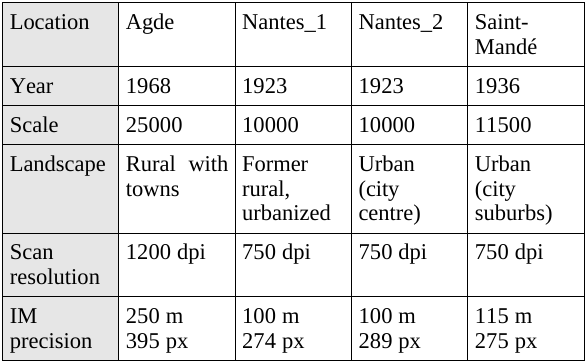
Table 1. Data specifications of the old photographs presented in Figure